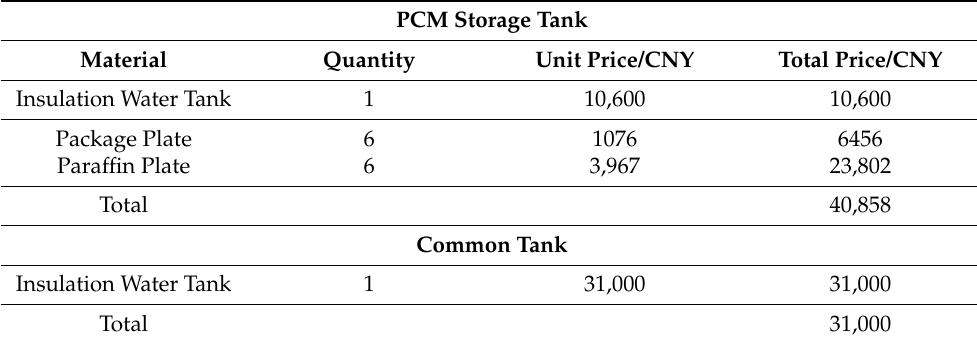
Table 4. Initial investment comparison of